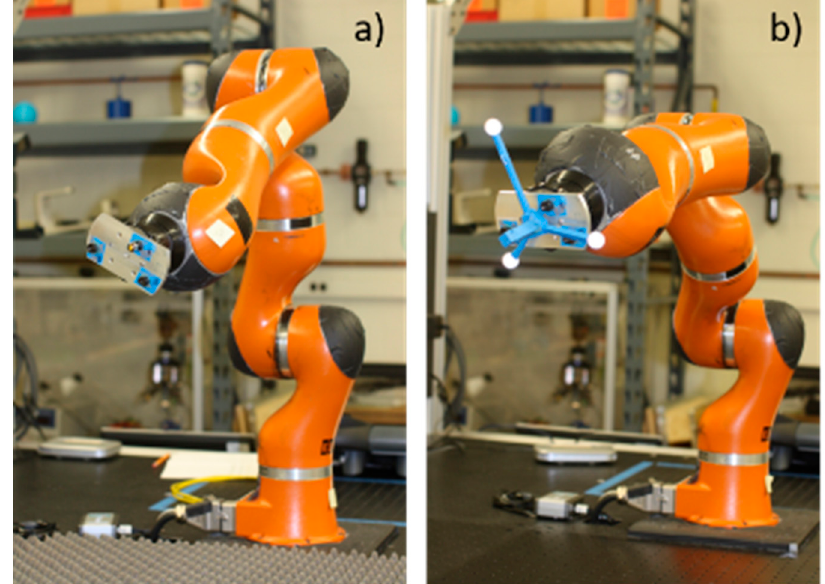
Figure 1. Robotic arm with two different sets of 3D markers used for pose determination: ( a ) a single SMR in one of three nests used for a laser tracker; and ( b ) a SIR marker configuration for the motion capture system.